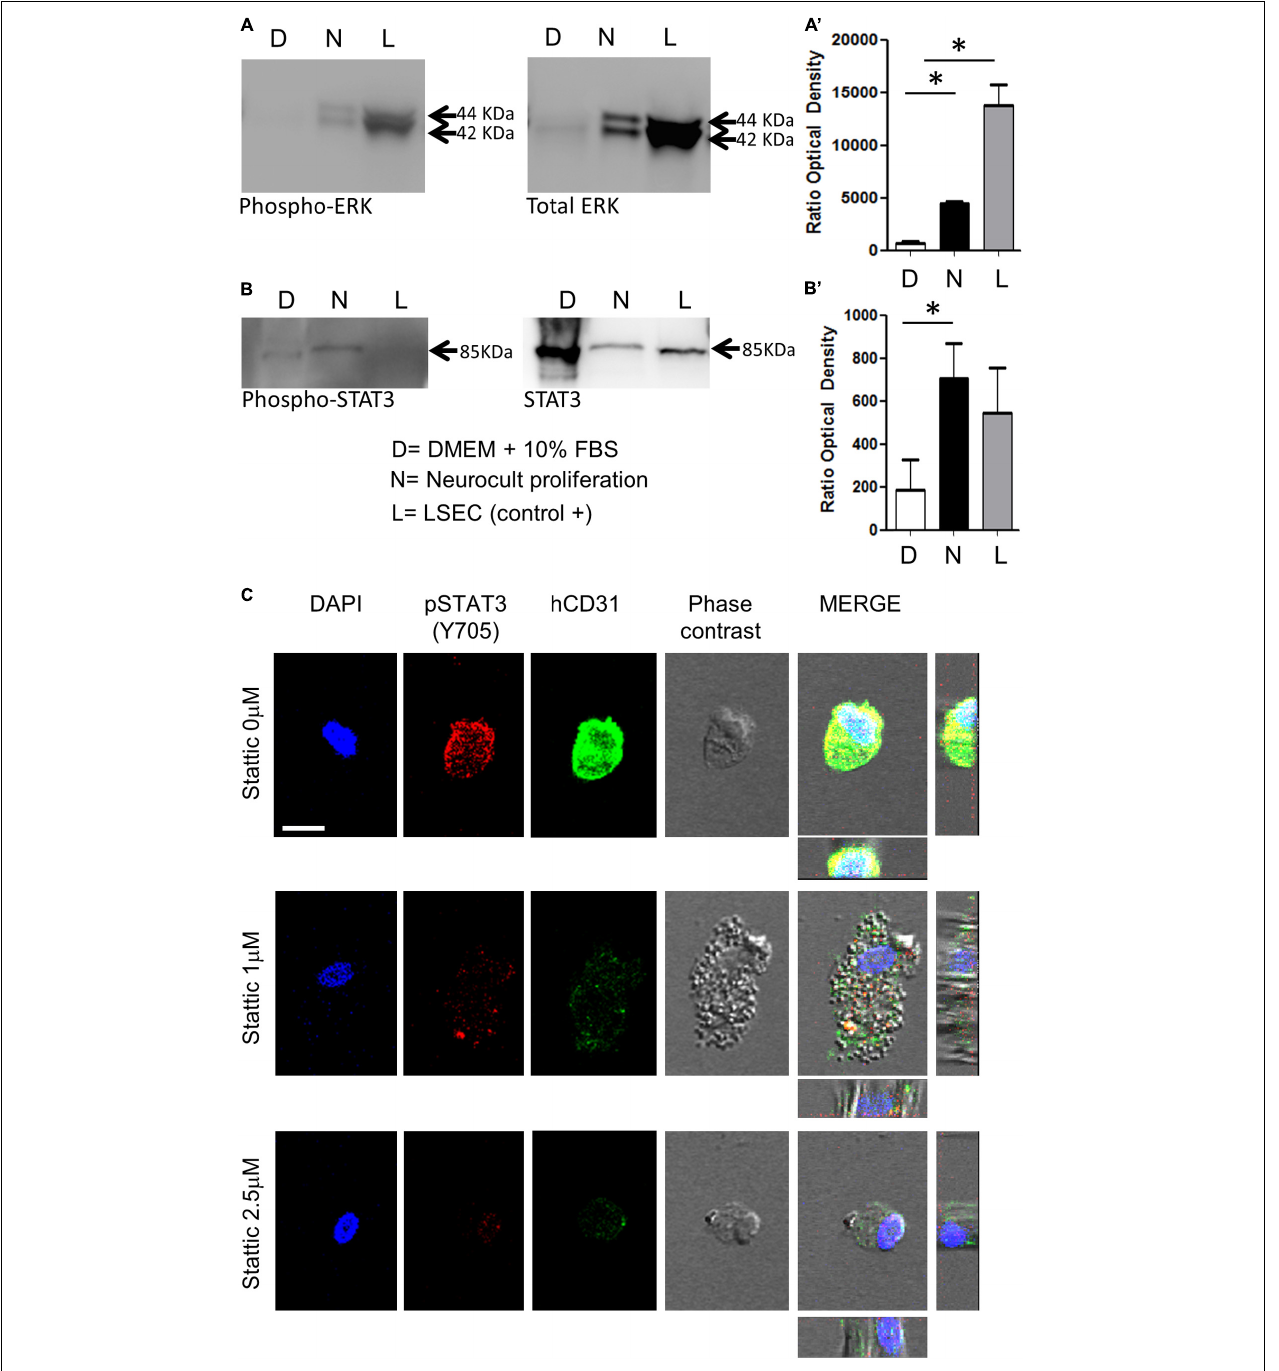
FIGURE 5 | DPSCs grown in Neurocult Proliferation activate both proangiogenic ERK and STAT3 signaling. Western blot membranes of 200,000 cells for each condition showing (A) phospho-ERK1/2 and total ERK protein levels and (B) phospho-STAT3 and total STAT3 for DPSCs grown either with DMEM + 10% FBS (D) or Neurocult proliferation (N) media. As a positive control, human liver sinusoidal endothelial cells (L, LSEC) were used. (A’) Quantification of phospho-ERK1/2 western blot in three different samples for each (D, N, L) condition [mean ± SEM; ∗ p = 0.04 (D vs N) and ∗ p = 0.0273 (D vs L); one-tailed Kruskal–Wallis test]. (B’) Quantification of phospho-STAT3 [mean ± SEM; ∗ p = 0.05 (D vs N); one-tailed Kruskal–Wallis test (full blotting of the gel is shown in Supplementary Material )]. (C) Immunofluorescence and orthogonal projection of phospho-STAT3 and human CD31 label of DPSCs grown with Neurocult proliferation medium during 72 h using different concentrations of the STAT3 inhibitor Stattic. At concentrations above 1 µ M, Stattic abolishes the expression of CD31 in DPSCs. Scale bar 10 µ m.